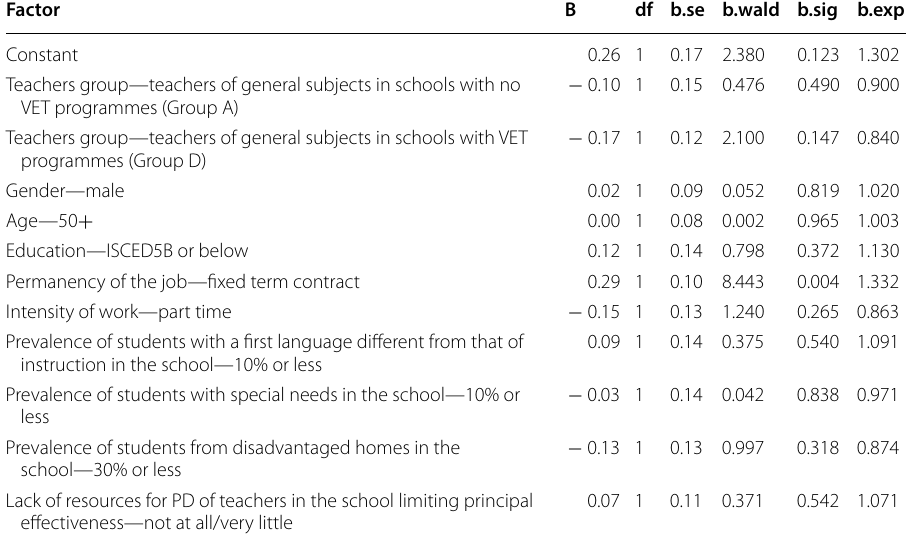
Table 19 Declaring cost as a barrier to professional development, results of the logistic regression model, regressors R1–R10, Italy, 2013 (Source: Author’s calculations based on OECD, TALIS 2013)